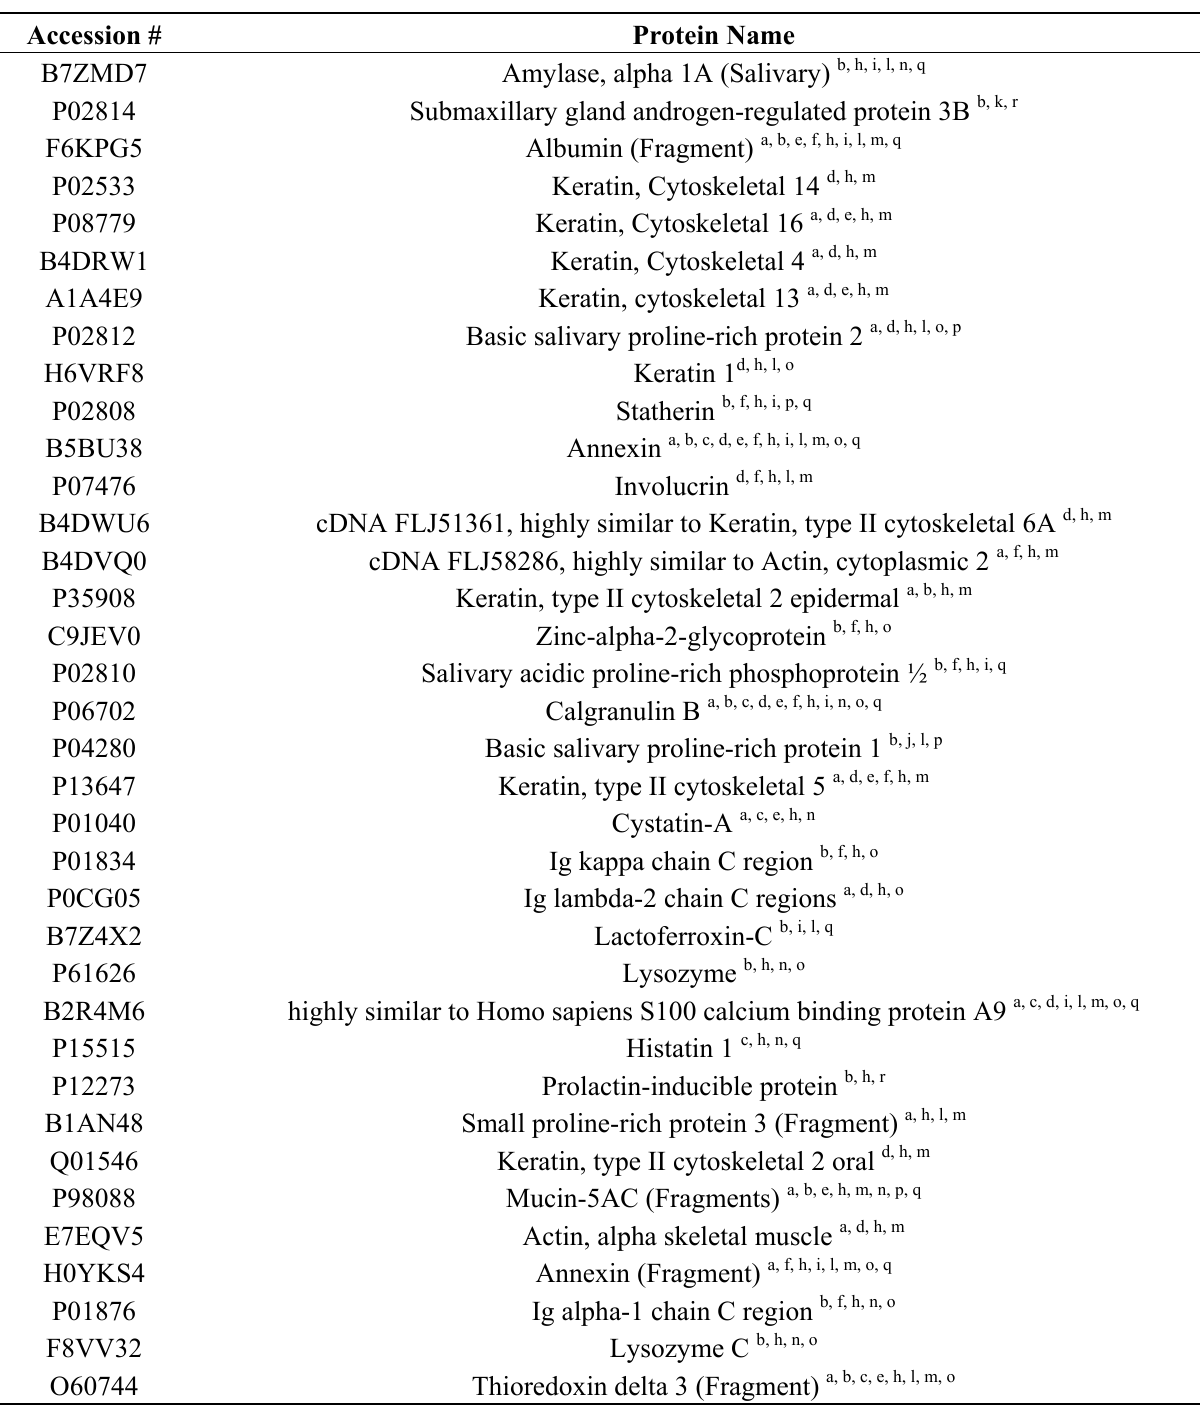
Table 1. Identified proteins from in vivo AEP formed on deciduous